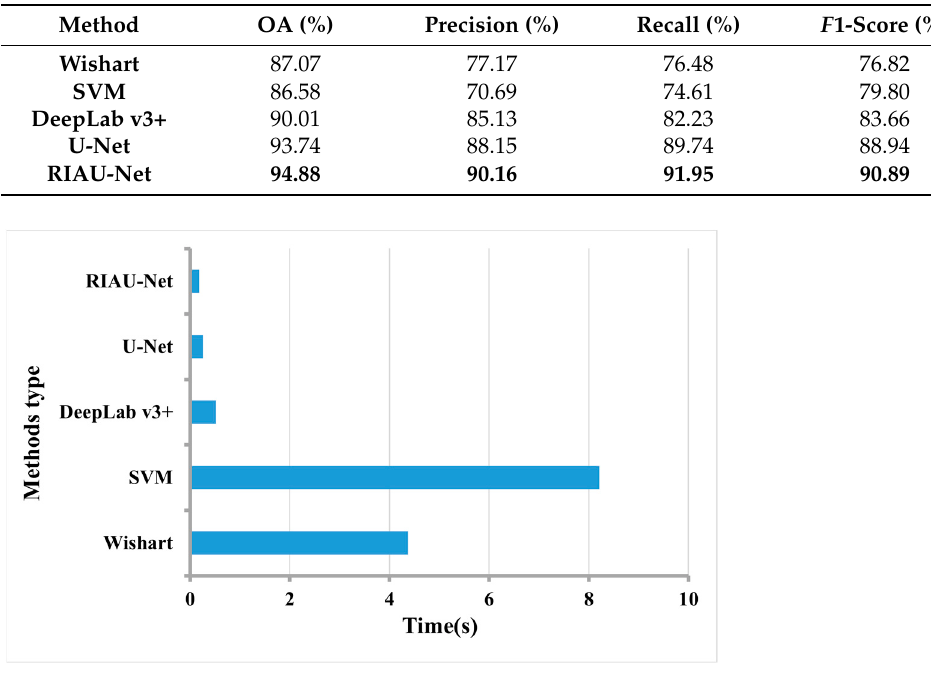
Figure 11. Inference time per image of the different methods. Table 5. Classification results of the different methods.